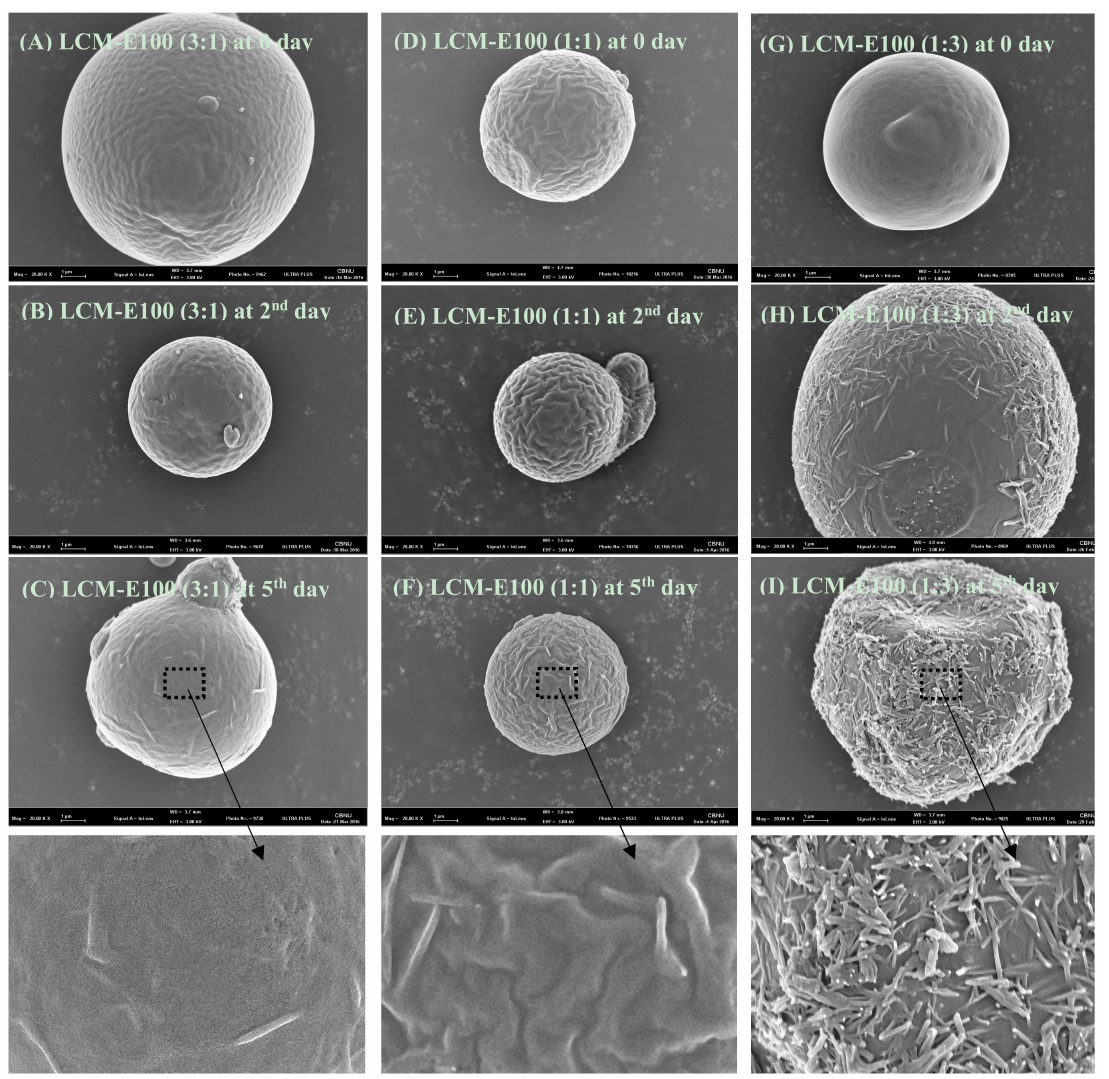
Figure 8. SEM images of the prepared formulations during the stability test. ( A – C ) show the SEM images of LCM-E100 (3:1); ( D – F ) show the SEM images of LCM-E100 (1:1); ( G – I ) show the SEM images of LCM-E100 (1:3) as 0, 2, and 5 days during stability